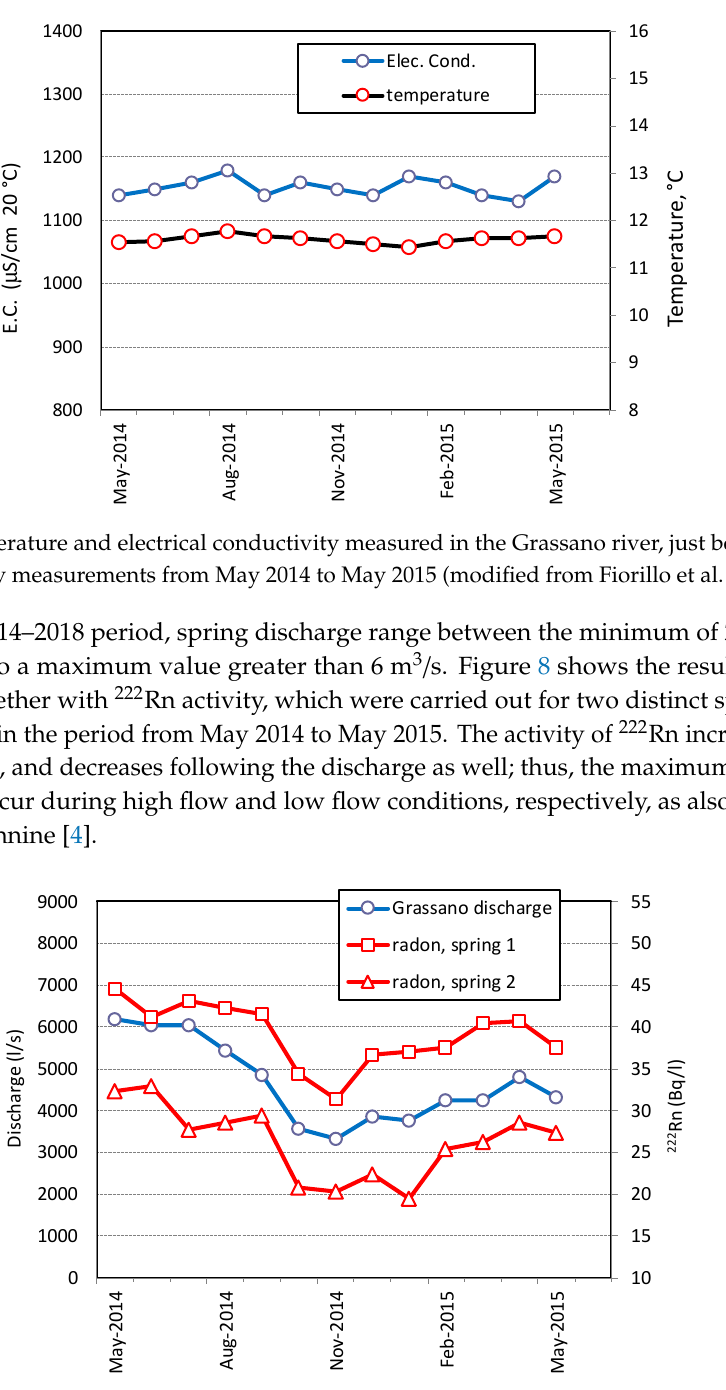
Figure 8. Radon ( 222 Rn) activity measured in two distinct spring outlets (1 and 2) of the Grassano group, and overall discharge of the Grassano; monthly measurements from May 2014 to May 2015.